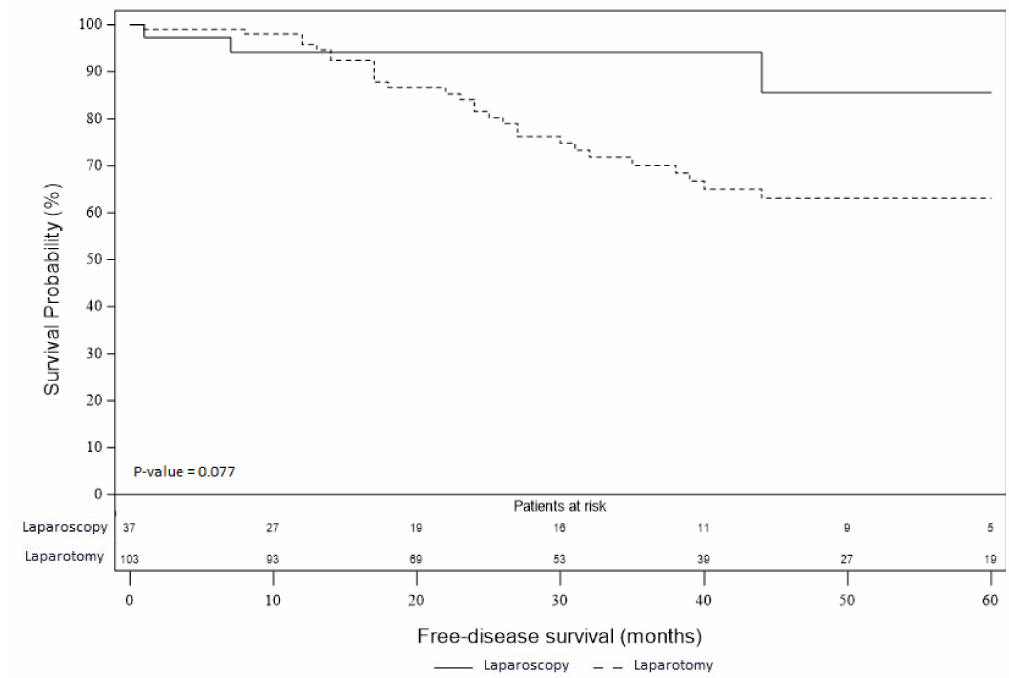
Figure 2. Recurrence-free survival of the laparoscopy and laparotomy groups.